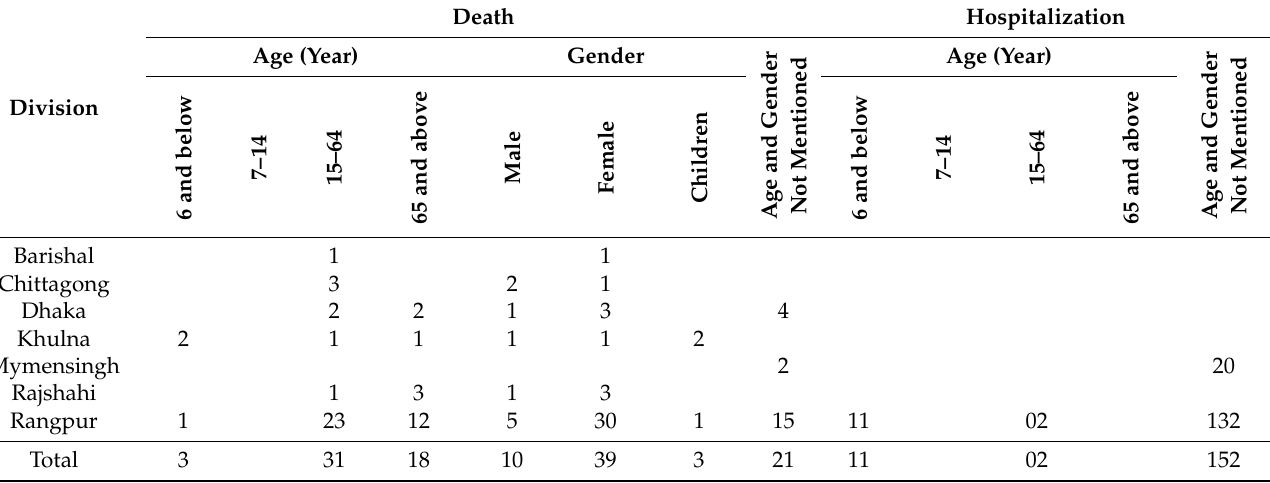
Table 3. Death and hospitalization due to campfire-related burns in the divisions of Bangladesh during the winter months of